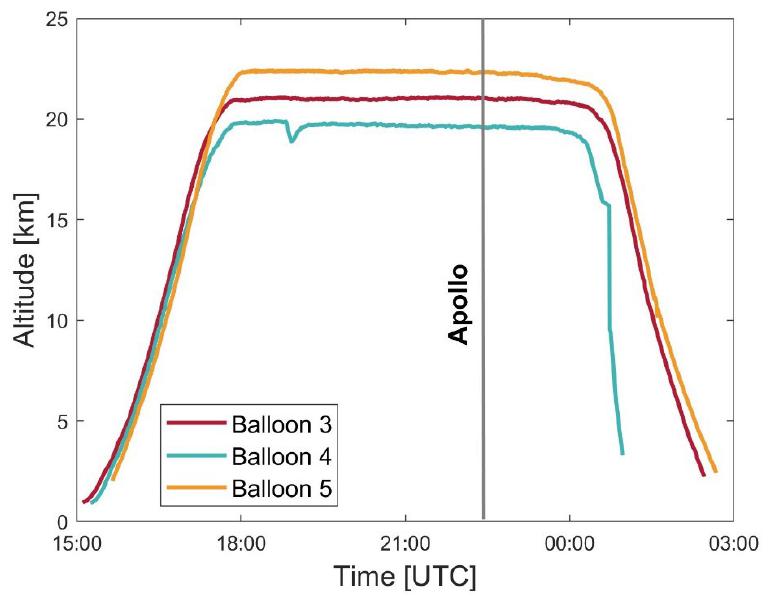
Figure 3. Altitudes of solar hot air balloons as a function of time. The detonation time is denoted with the vertical line.